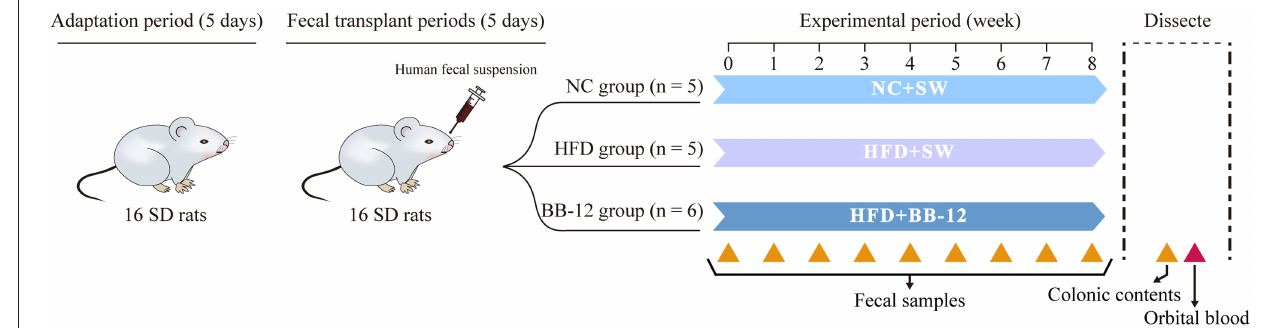
FIGURE 1 | Group information of HMA-SD rat models. After 5 days of adaptation, human fecal suspension was intragastrically administered every 2 days three times to build the HMA-rats model. Then, the 16 HMA-SD rats were randomly divided into 3 groups for a 8-week trial. The normal chow (NC) group, 8 weeks of NC and daily administration of sterile water gavage, as negative control; the high-fat diet (HFD) group, 8 weeks of HFD and sterile water gavage; the BB-12 group, 8 weeks of HFD and BB-12 gavage. HMA-SD, human microbiota-associated-Sprague-Dawley; SW, sterile water; TKM, Tibet kefir milk; 16S rRNA, 16S ribosomal RNA. Yellow triangle up solid, sampling sites for 16S rRNA sequencing; red triangle up solid, sampling sites for serum lipid